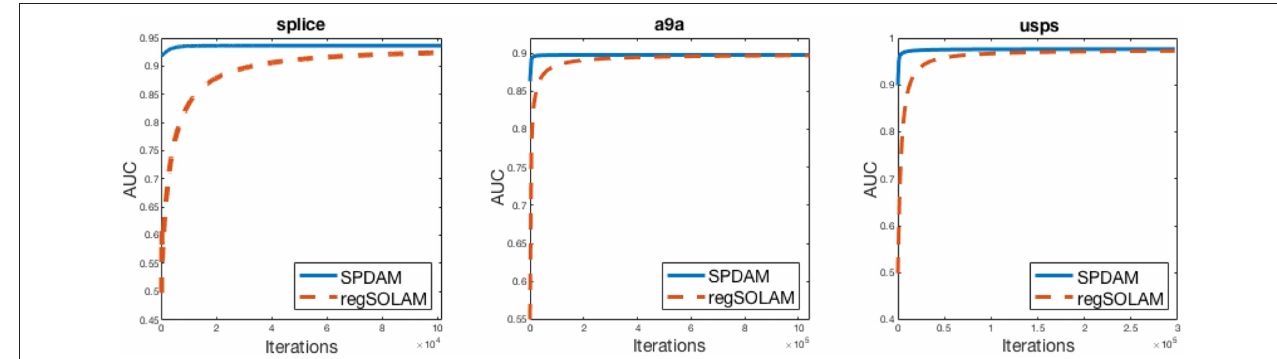
FIGURE 1 | AUC vs. Iteration curves of SPDAM against regSOLAM. For SPDAM, 10% of the data was chosen for a batch size. The optimal value of the parameter λ from SPDAM was used in regSOLAM.